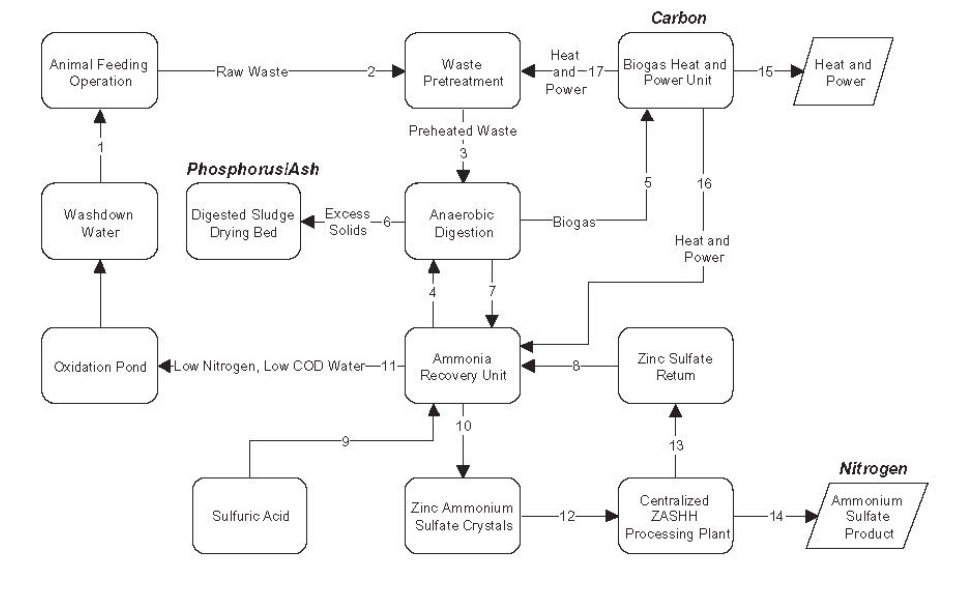
FIGURE 3. ThermoEnergy Biogas System process flow